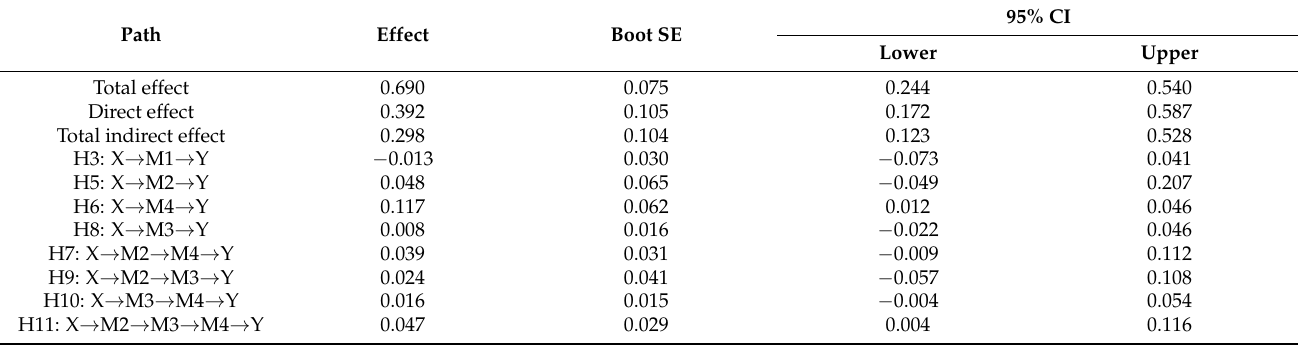
Table 5. Serial mediating effect of technology acceptance and learning satisfaction.